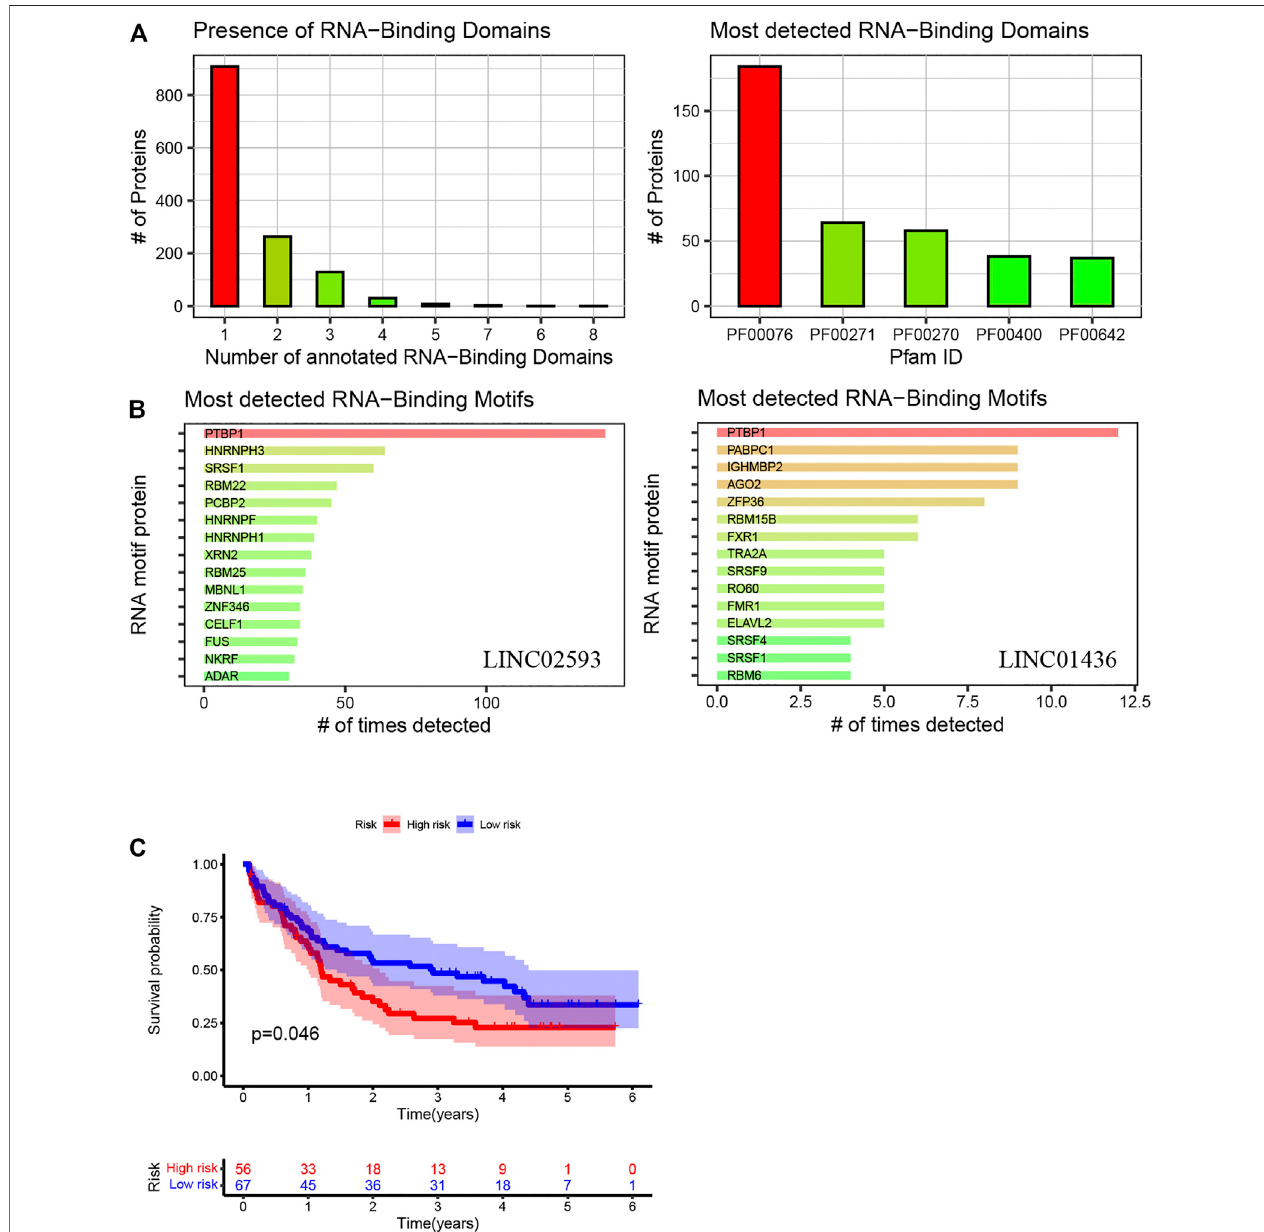
FIGURE 11 | Using the method of LNCipedia (Volders et al., 2019) and catRAPID (Armaos et al., 2021), transcripts are clustered into genes. (A,B) indicate the presenceofproteinnucleic-acid-bindingdomainsorRNArecognitionmotifsinLINC01436andLINC02593. (C) Kaplan – Meiercurvesofhigh-andlow-riskgroupsinthe validation cohort. The X- and Y -axes represent the time and probability of survival, whereas the red and blue lines represent the high- and low-risk groups, respectively.